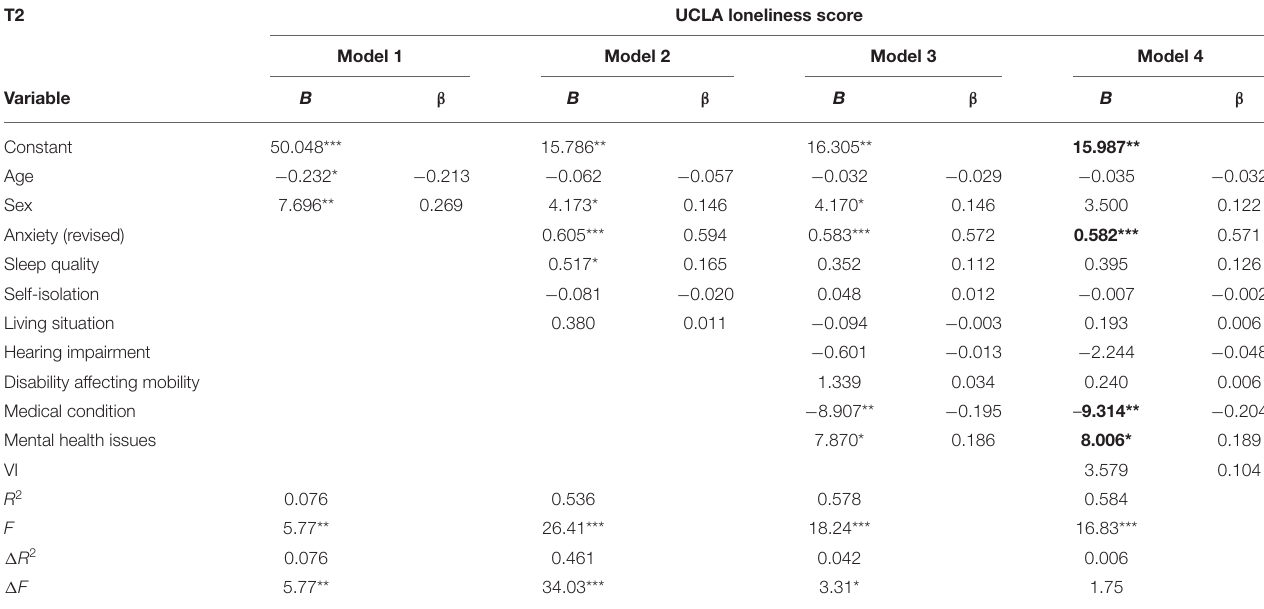
N = 144. B = unstandardized regression coefficient; β = standardised coefficient; R 2 = coefficient of determination; 1 R 2 = R 2 change; 1 F = F change. * p < 0.05. ** p < 0.01. *** p < 0.001. Bold values in Model 4 denote significant predictors.